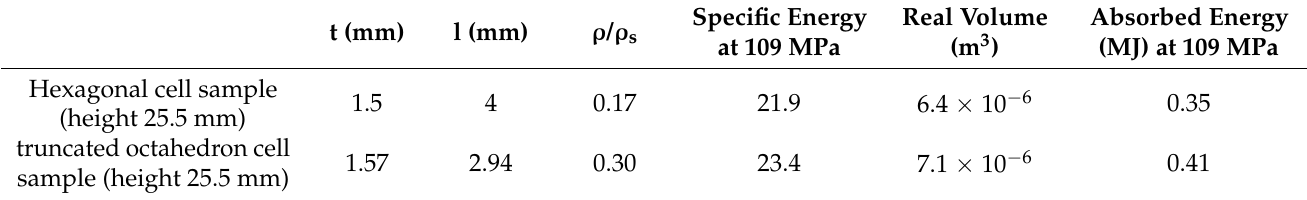
Table 3. Comparison of geometrical properties, relative density, and energy absorption for the two best performing manufactured